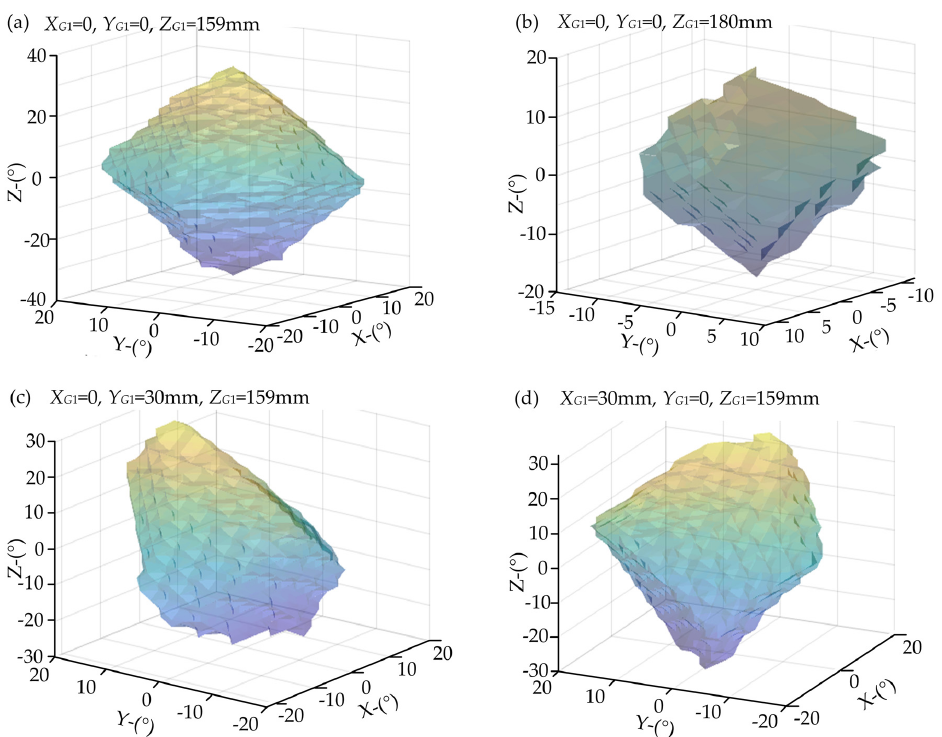
Figure 6. The orientation ROM of the external fixator. ( a ) The orientation ROM of the fixator when the position is (0,0,159) which is the middle position among the reachable position along the z-axis of the external fixator. ( b ) The orientation ROM of the fixator when the position is (0,0,180). ( c ) The orientation ROM of the fixator when the position is (0,30,159). ( d ) The orientation ROM of the fixator when the position is (30,0,159).